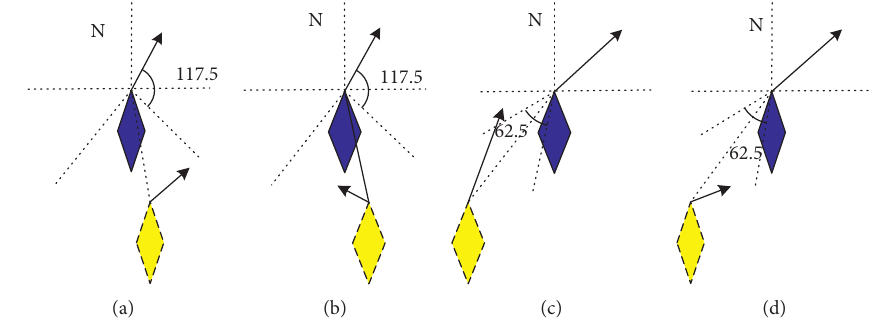
Figure 10: Overtaking situation (own ship is a direct ship).